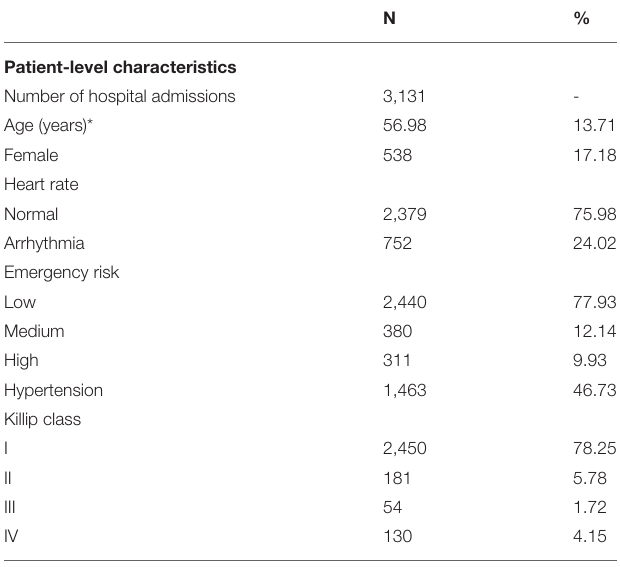
TABLE 1 | Patient-level characteristics of study participants.